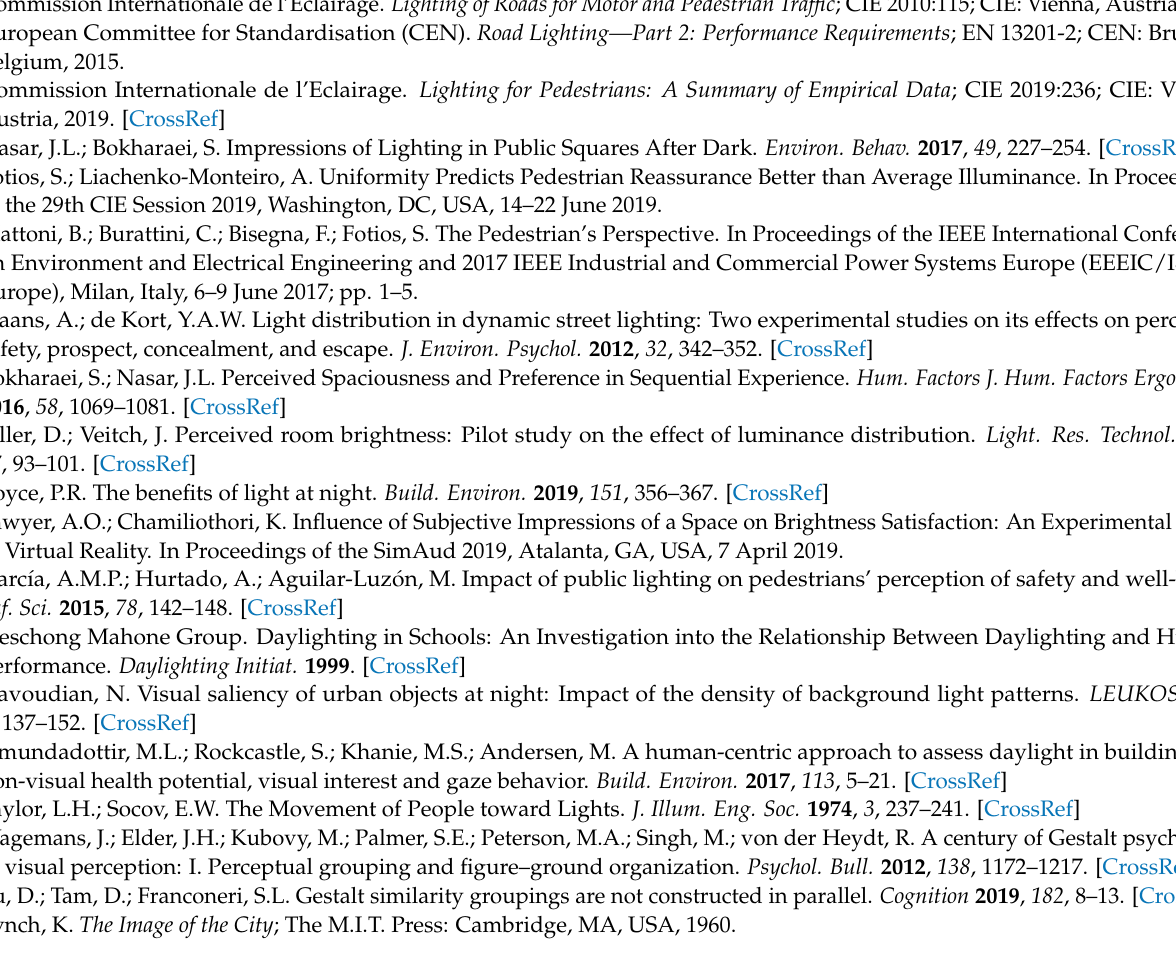
Figure A3. Reflective sketches from Ljungarum, showing possible implications from lighting variations (from left to right, top to bottom): ( a ) The spill light falling on the nearest trees makes the walkway lively and personal. The problem is the darkness behind them. This is the lighting of today. ( b ) By adding light shining a few meters into the dark forest, the contrasts will be reduced and reveal any possible attacker hiding there.